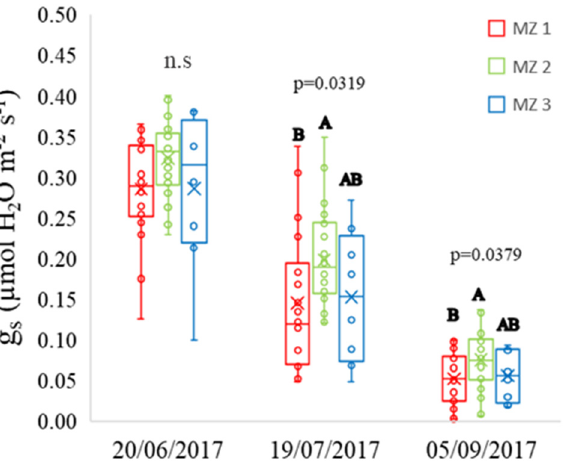
Figure 10. Stomatal conductance to water vapor (g s ) on three days, representing different pheno- logical stages: 20 June 2017—bunch closure, 19 July 2017—veraison and 5 September 2017—har-